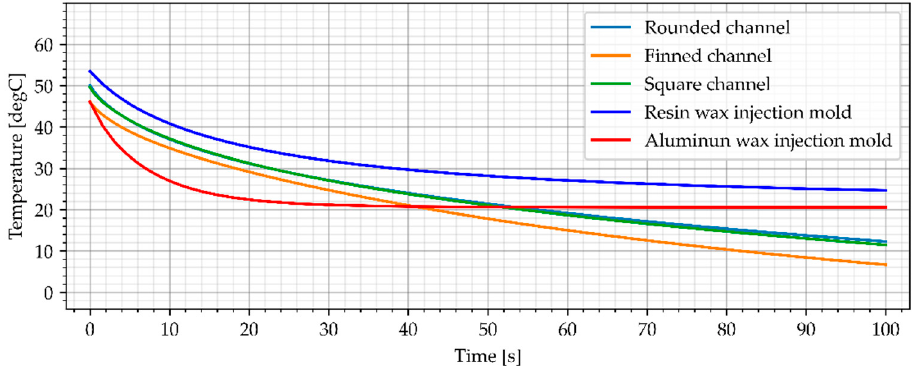
Figure 19. The average temperature of the sample.